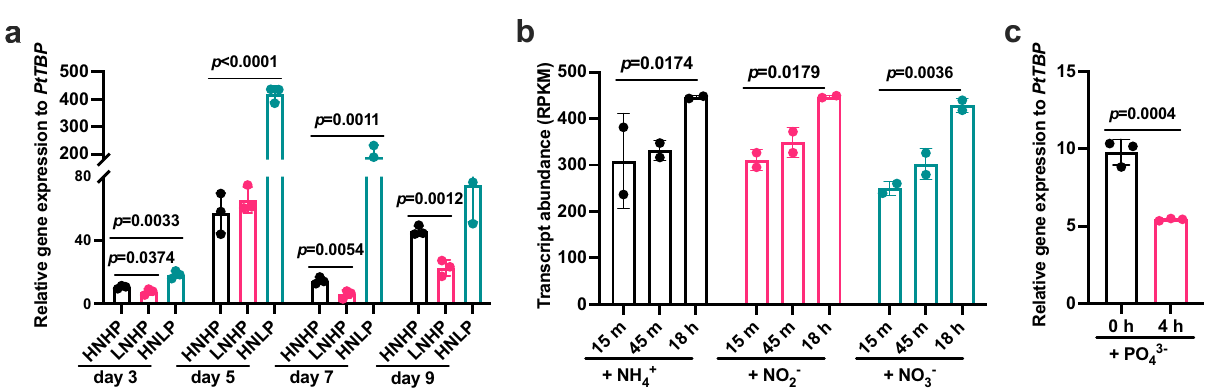
Fig. 2 Involvement of PtTryp2 in nitrogen and phosphorus nutrient responses. a PtTryp2 expression in P. tricornutum under different growth stages and conditions based on qRT-PCR. Nutrient-replete, HNHP; N-depletion, LNHP; P-depletion, HNLP. Data are presented as mean values± SD ( n = 3 biologically independent samples). The comparisons between the averages of the two groups were evaluated using the one-tailed Student ’ s t test. The p values with signi fi cance ( p ≤ 0.05) are shown. b Time-course expression patterns of PtTryp2 when P. tricornutum was grown with different forms of nitrogen nutrients. Data are presented as mean values ± SD ( n = 2 biologically independent samples). The comparisons between the averages of the two groups were evaluated using the one-tailed Student ’ s t test. The p values with signi fi cance ( p ≤ 0.05) are shown. c PtTryp2 expression pattern after phosphorus supplement. Data are presented as mean values ± SD ( n = 3 biologically independent samples). The comparisons between the averages of the two groups were evaluated using the one-tailed Student ’ s t test. The p values with signi fi cance ( p ≤ 0.05) are shown. Source data are provided as a Source Data fi le.